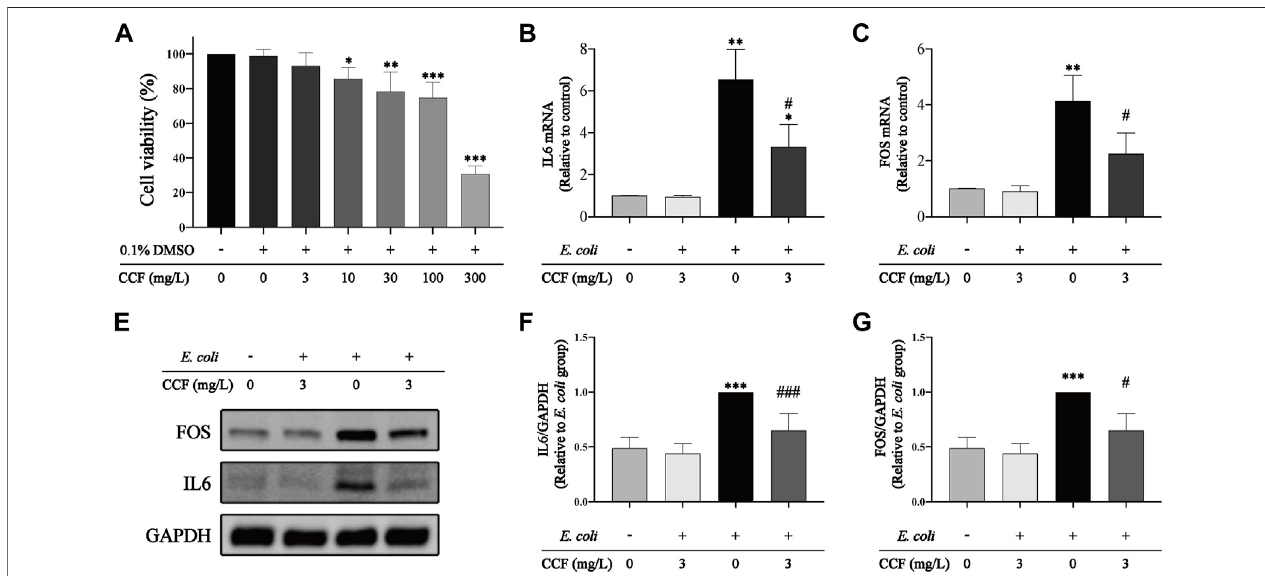
FIGURE 10 | Effect of CCF intervention on cell proliferation and the expression of IL6 and FOS. (A) Cell proliferation was examined by the CCK-8 assay; (B – C) transcriptional levels of IL6 and FOS were detected by qPCR, and GAPDH was used as an internal control to normalize the data; (D) representative WB bands of IL6, FOS, and GAPDH; (E – F) statistical analysis ofIL6/GAPDHand FOS/GAPDHrelative expression. The presented data were presented as means ± S.D., n (cid:1) 6. * p < 0.05, ** p < 0.01, and *** p < 0.001 compared with the control group; # p < 0.05, ## p < 0.01, and ### p < 0.001 versus the E. coli alone group, performed by the one-way ANOVA with LSD post hoc comparisons or Dunnett ’ s T3 post hoc